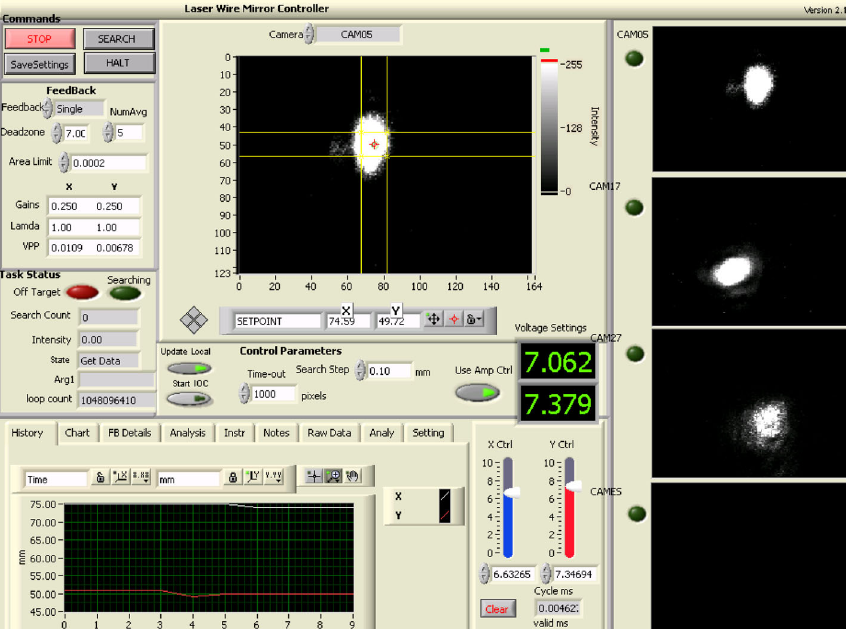
FIG. 3. Feedback-based laser beam position stabilization program. Beam positions are monitored by image sensors (Ethernet cameras) at three locations: CAM27, CAM17, and CAM05 which represent cameras installed at CM27, CM17, and CM05, respectively. Feedback is conducted based on beam positions on one or multiple image